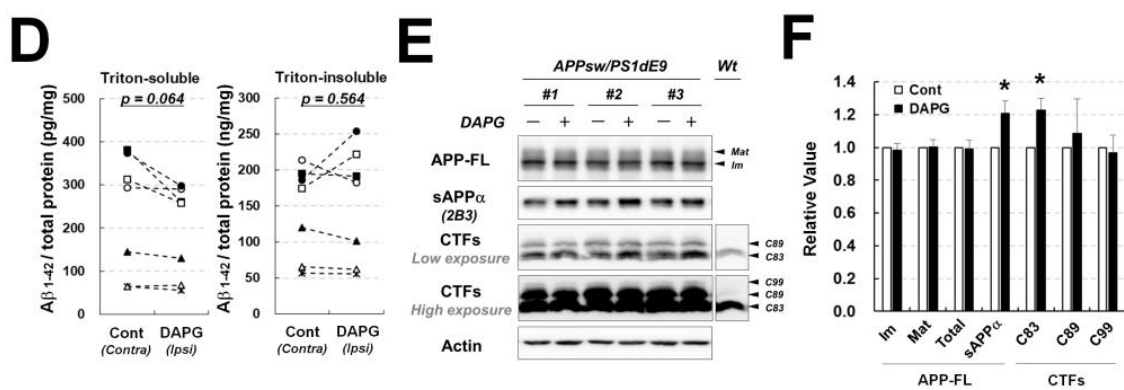
Figure 6. Examination of DAPG effects on A β levels and APP processing after DAPG intrahippocampal injection. ( A ) Computational prediction of blood–brain barrier permeability to DAPG using online prediction software available at http://www.cbligand.org/BBB, accessed on 26 July 2022. ( B ) Schematic illustration of DAPG intrahippocampal injection and further analyses, including immunoblot and A β ELISA assays, in 8-month-old APPsw/PS1dE9 transgenic mice. Detailed methods for DAPG injection and A β analysis are described in Materials and Methods. ( C , D ) ELISA analysis of A β 1–40 ( C ) and A β 1–42 ( D ) levels obtained in Triton-soluble and Triton-insoluble (or GuHCl-soluble) fractions from control and DAPG-injected hippocampi. In the graph, the values obtained for control (contralateral) and DAPG-injected (ipsilateral) hippocampi were statistically paired. Paired t -tests were used to determine the statistical significance of the differences (n = 7) and the resultant p-values are plotted on the graph. ( D , E ) Immunoblot analysis of APP processing ( E ) in control and DAPG-injected hippocampi from the transgenic mice and densitometry analysis of the immunoblots ( F ). Values in ( F ) are presented as means ± SEMs (n = 7). Statistical significances of difference between the injected and uninjected groups were determined using paired t -test (* p <